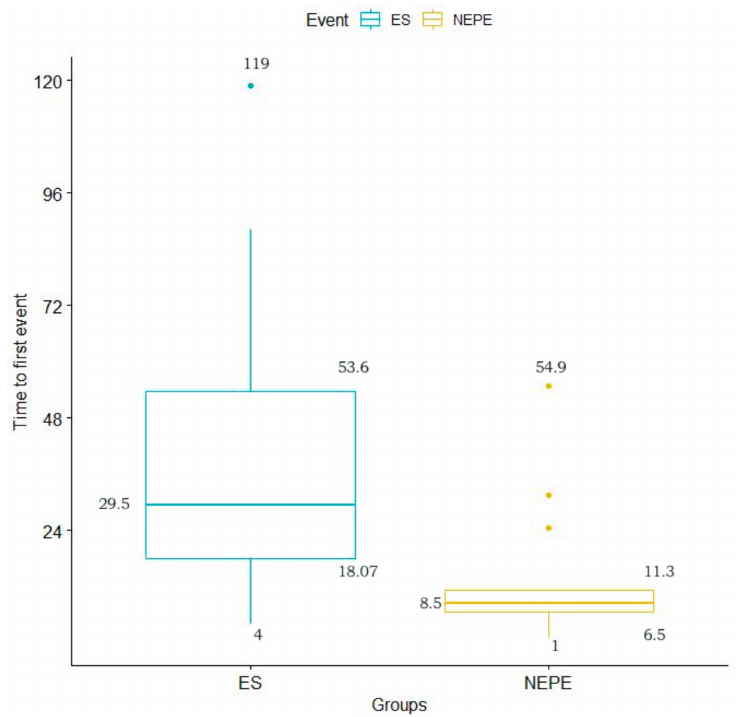
Figure 3. Average time of appearance of the first recorded event among the groups of